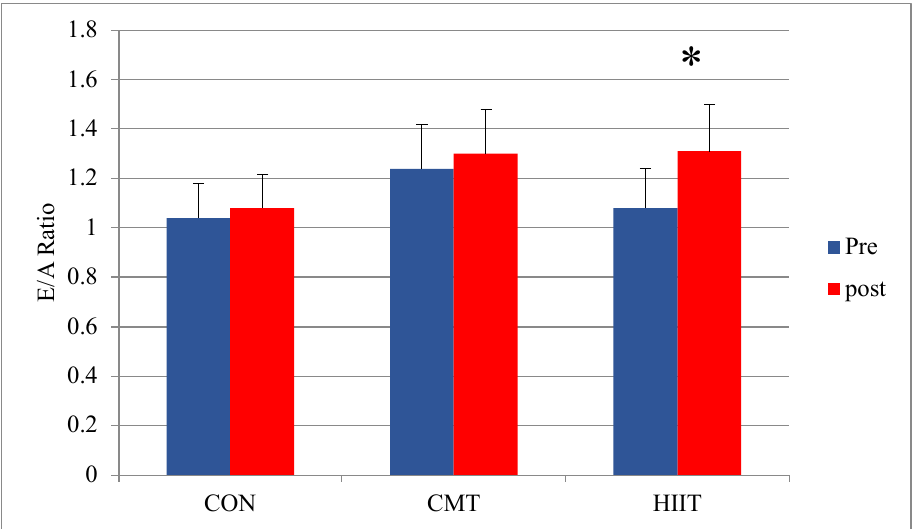
Figure 7. Mean LV E/A Ratio (Left Ventricle Function) Changes before and after 12 Weeks of CMT and HIIT; * Indicates a significant increase compared with the control group ( p < 0.05). E/S Ratio: Early Filling Rate Divided by Secondary Filling Rate (Left Ventricle Function). CON: Control. CMT: Continuous Moderate Training. HIIT: High-Intensity Interval Training.